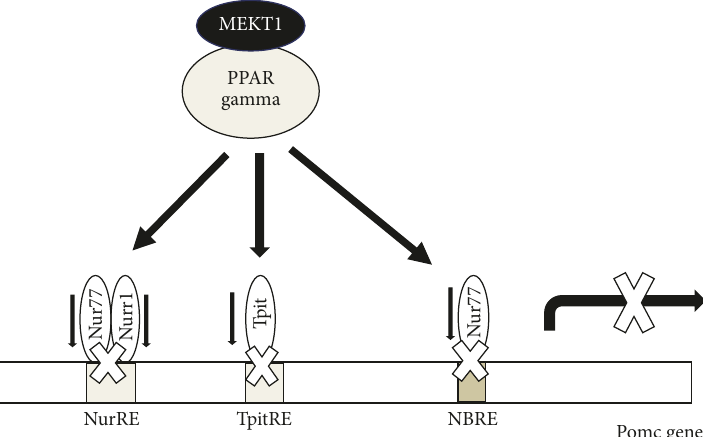
Figure 11: Involvement of Nur77, Nurr1, and Tpit transcription factors in the MEKT1 (PPAR- 𝛾 agonist)-mediated suppression of Pomc .